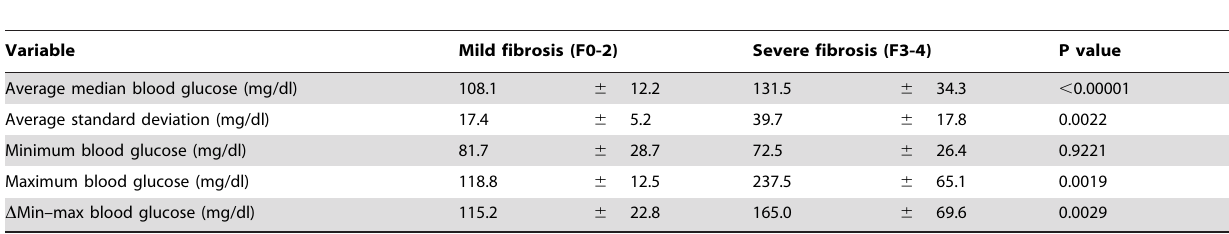
Table 4. Comparison of variable parameters of continuous glucose monitoring between patients with mild fibrosis (F0–2) and severe fibrosis